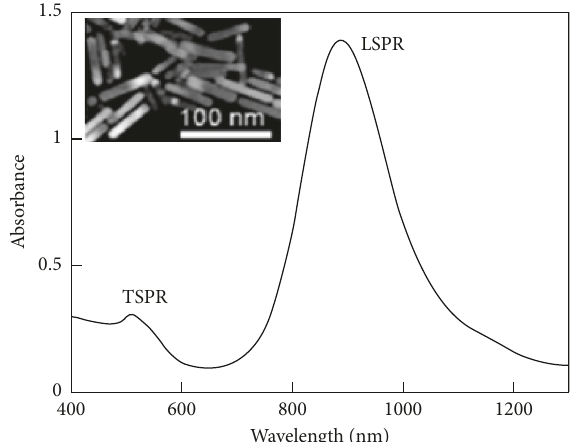
Figure 10: PC-AuNRs absorption spectrum, 0.5nM Au nanorods (TEM image of